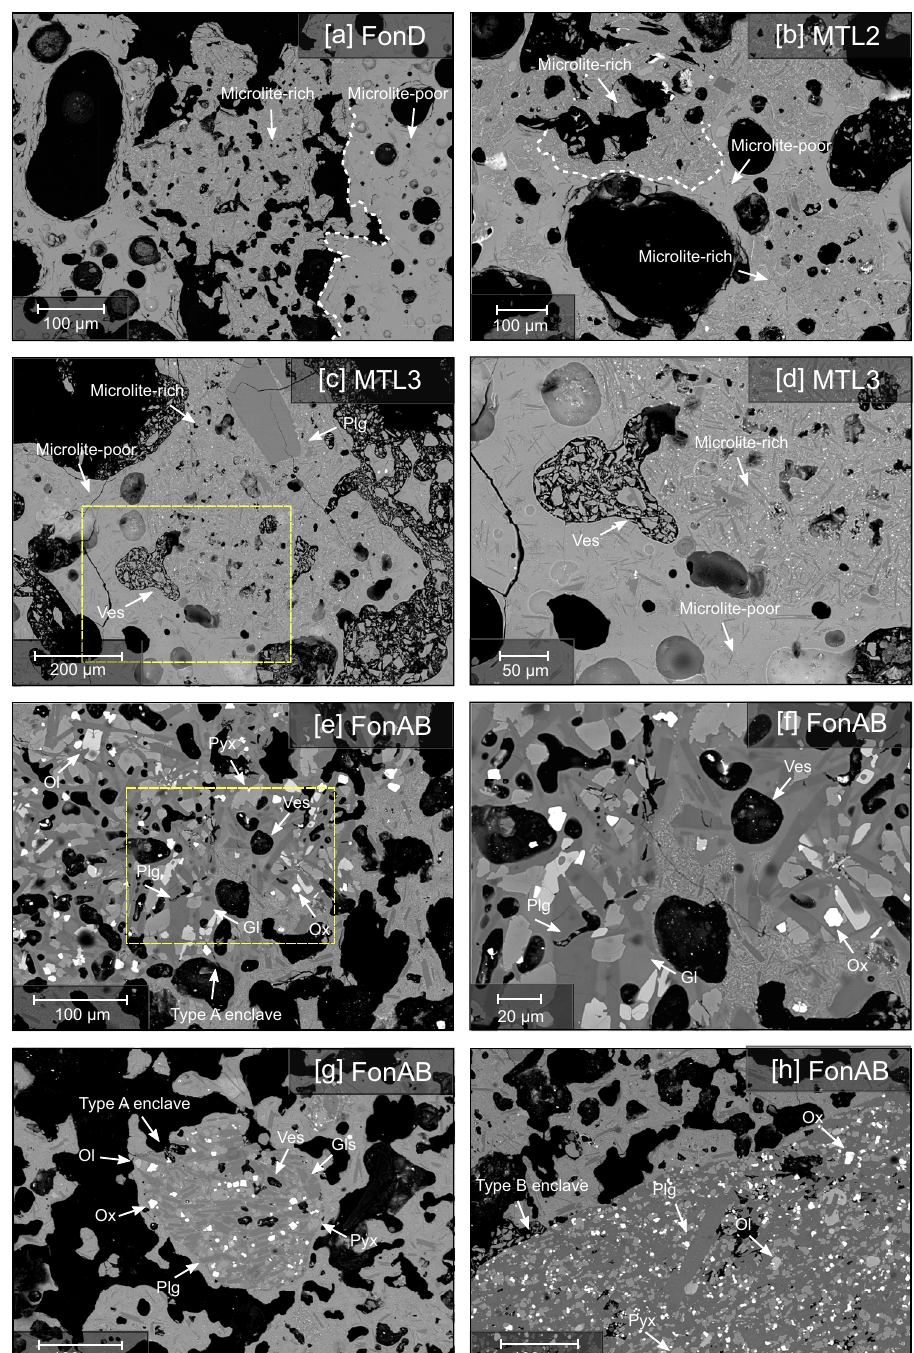
Fig. 2 Back-scattered electron images of key microtextural features observed in scoriae. Scoriae are from the Fontana Lapilli (Fon) ( a , e – h ) and Masaya Triple Layer (MTL) ( b – d ) eruptions. ( a ) Microlite-poor and microlite-rich regions, exhibiting different crystal fractions and vesicle morphologies. The boundary between the two regions is highlighted by the white line. ( b ) Mingling region between microlite-poor and microlite-rich regions. The white line highlights the boundary between the two regions. ( c ) Mingling region between microlite-poor and microlite-rich regions. Vesicle size and morphology differs between regions of varying crystallinity. ( d ) Higher magni fi cation image of ( c ) showing the larger vesicles which extend into both the microlite-poor and microlite-rich regions. ( e ) Type A enclave, with an irregular, deformed contact and largely vesiculated (Ves) interstitial glass (Gl). Plagioclase (Plg), pyroxene (Pyx), olivine (Ol) and oxide (Ox) crystals are labelled. There is subparallel alignment of microlites with the surrounding matrix. ( f ) Higher magni fi cation image of ( e ), showing the boundary between the Type A enclave and the matrix and vesicles within the interstitial glass. ( g ) Type A enclave showing preferred orientation of plagioclase, pyroxene and oxide microlites. ( h ) Type B enclave, with crystal alignment discordant to surrounding matrix microlites and a small amount of interstitial